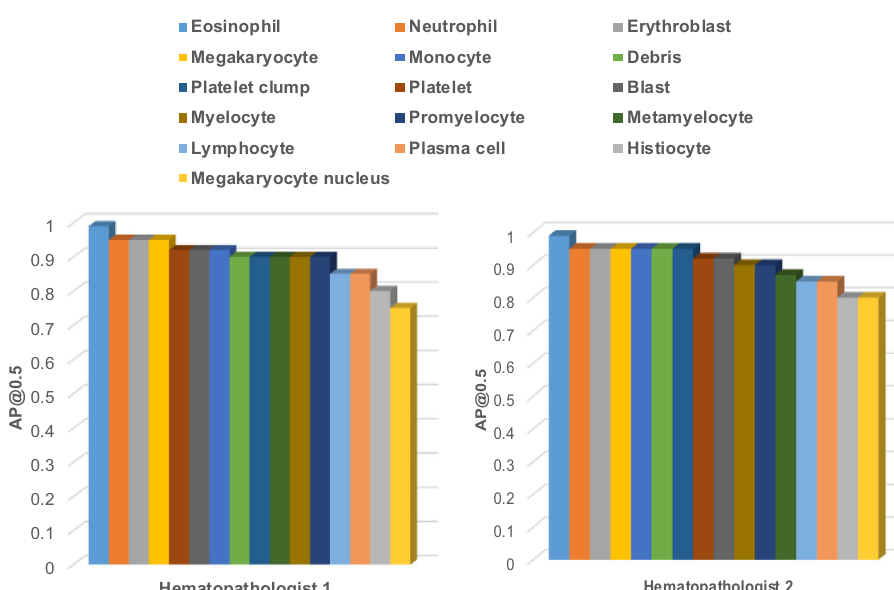
Fig. 6 Concordance between hematopathologists evaluation and the obtained results. Hematopathologists' evaluation for the cell detection and classi fi cation based on calculated average precision (AP) for each